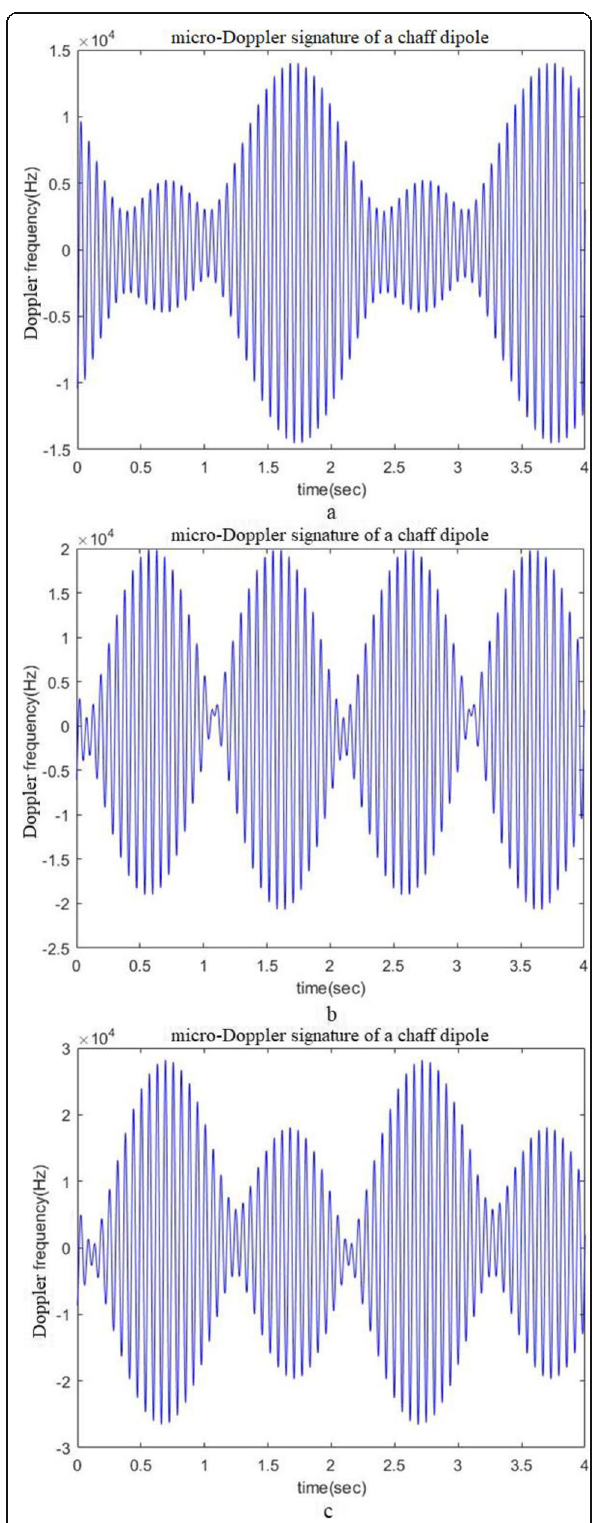
Fig. 6 Micro-Doppler frequency of single chaff dipoles with different azimuths (in the reference coordinates): a θ = 30 ∘ , φ = 60 ∘ , d r = 722 m , b θ = 30 ∘ , φ = 120 ∘ , d r = 722 m , and c θ = 30 ∘ , φ = 180 ∘ , d r = 722